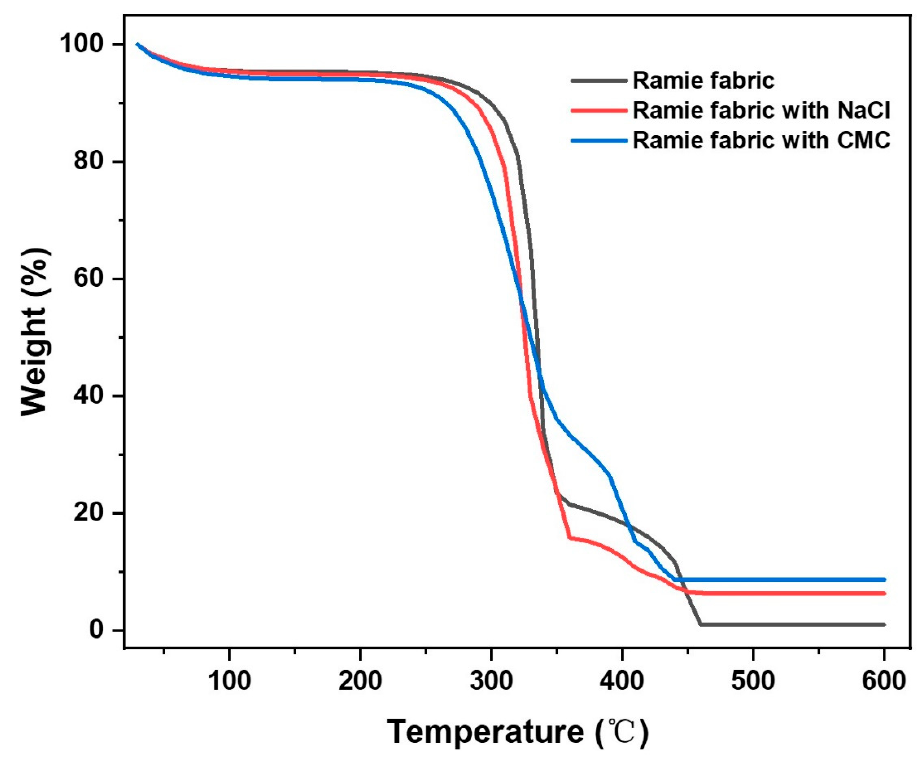
Figure 3. Thermogravimetric curves of different ramie fabrics in air.